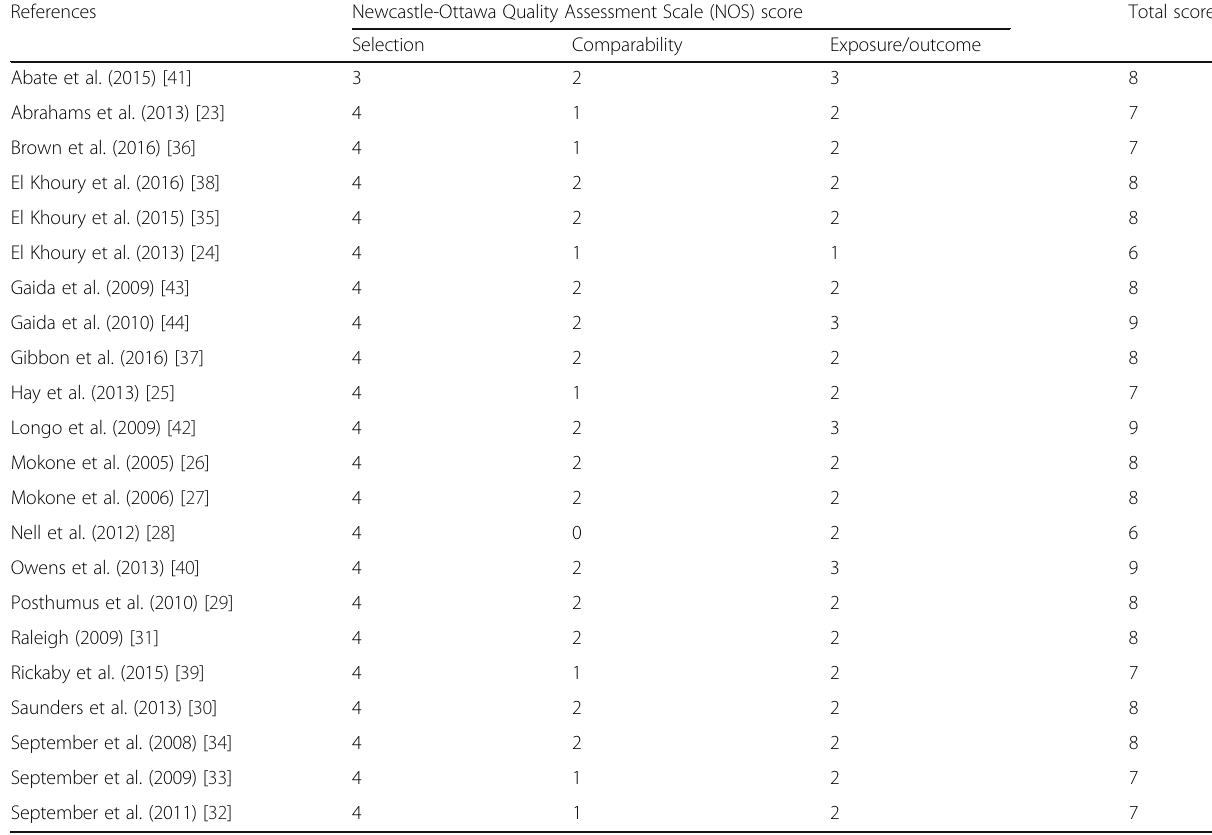
Table 1 The quality of the studies according to the Newcastle-Ottawa Quality Assessment